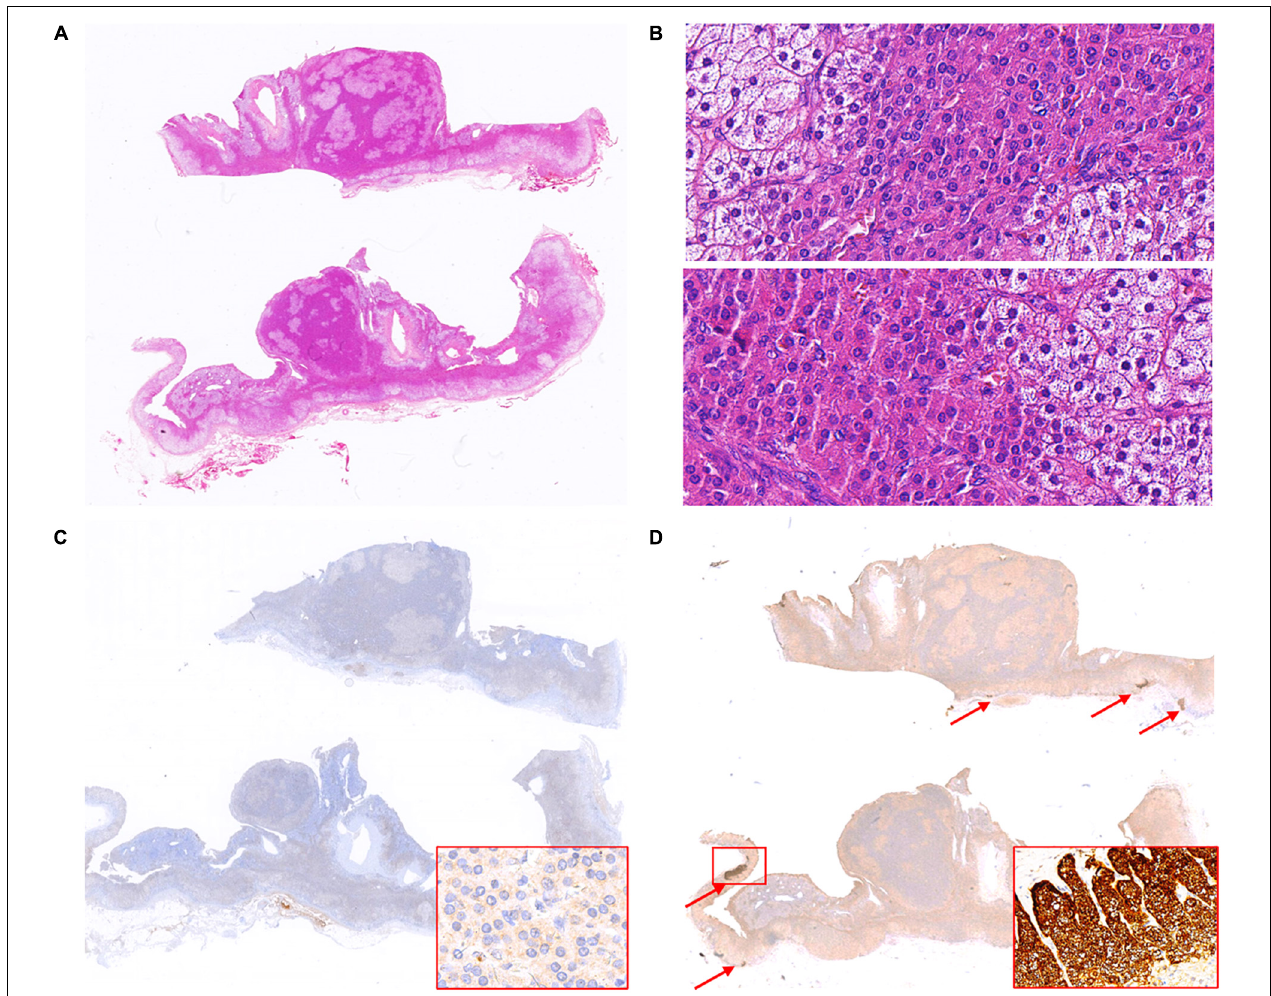
FIGURE 2 | Hematoxylin and eosin (H&E) and immunohistochemical staining of CYP11B1 and CYP11B2 in case 13. Two well-demarcated nodules in adrenal ( A , up and down); two nodules both composed of acidophilic cells and clear cells ( B , 400 × magnification for nodules respectively, up and down). Weak expression of CYP11B1 ( C , 400 × magnification for insert), completely negative staining of CYP11B2 in both nodules, several APCCs detected in the adrenal cortex ( D , indicated by red arrows, 200 × magnification for